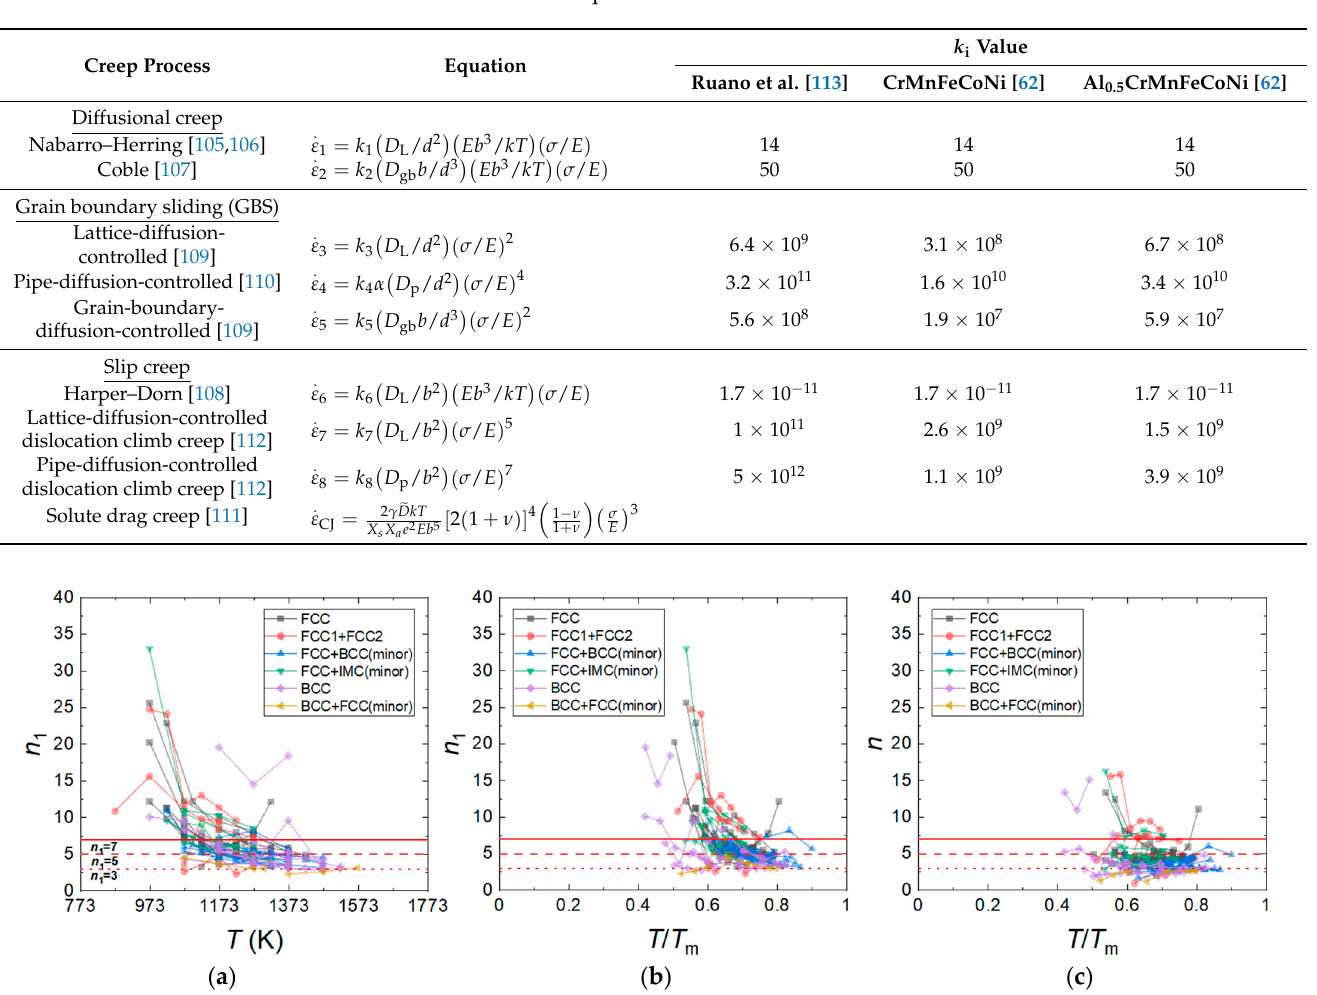
Table 2. The constitutive equations of deformation mechanisms in HEAs.